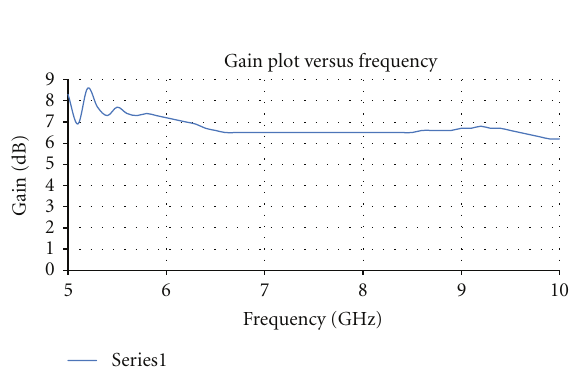
Figure 17: Plot of gain versus